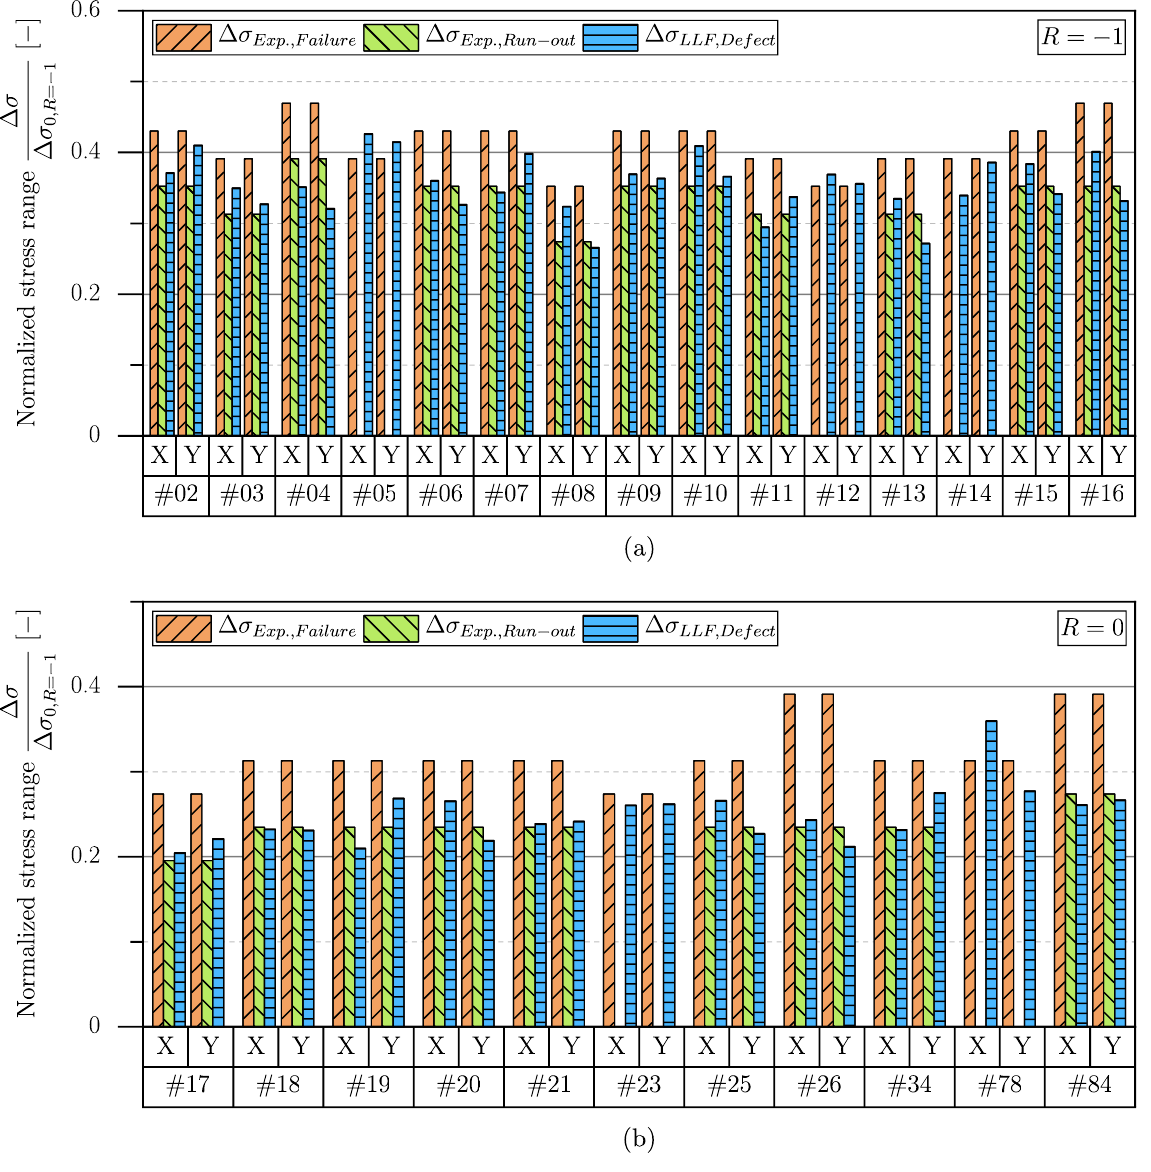
Figure 12. Validation results of the SED analysis of defect-afflicted cast steel specimens: ( a ) Specimens tested at R = − 1; and ( b ) specimens tested at R =